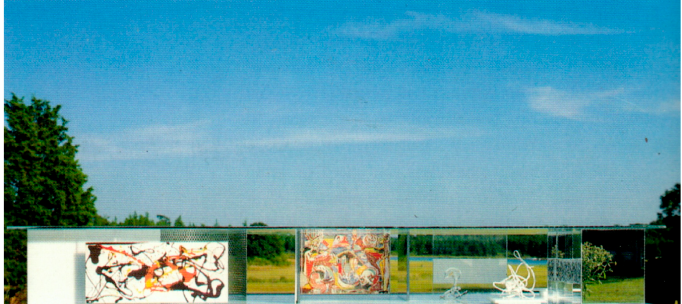
Figure 22. Peter Blake, “Ideal Museum” for Jackson Pollock’s work, 1949. © Peter Blake. All rights reserved, DACS/Artists Rights Society (ARS), New York 2022. Original model lost. Replica fabricated by Patrick Bodden, with sculptures by Susan Tamulevich, 1994–1995. Reconstructed model in landscape. Made possible by a grant from the Graham Foundation for Advanced Studies in the Fine Arts. Photograph by Jeff Heatley, collection of the Pollock-Krasner House and Study Center, East Hampton, N.Y. Summertime is visible on the extreme right.